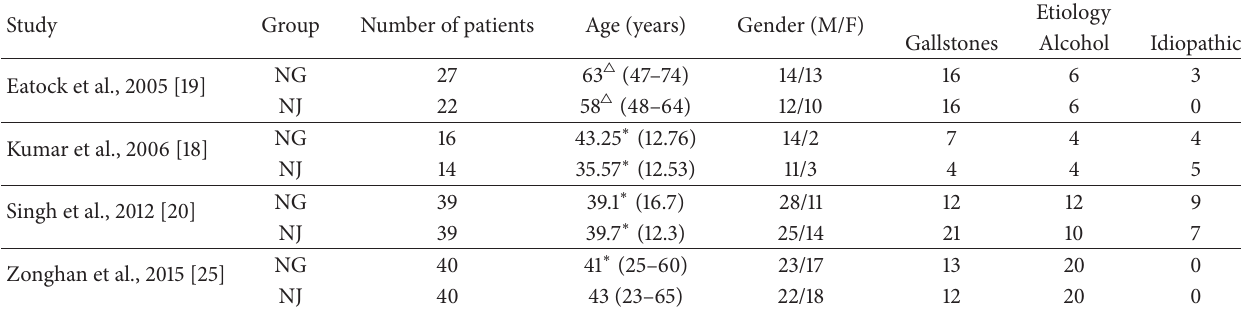
Table 2: Basic demographic characteristics of the patients in the included studies.